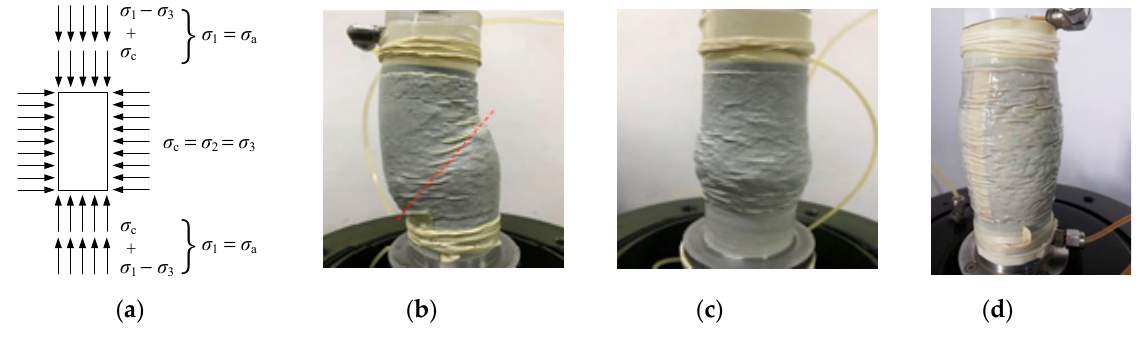
Figure 6. Stress State and Failure Mode of Specimens with a cement content of 3.5 g/100 mL. ( a ) Sample stress state, ( b ) Failure mode with X = 10%, ( c ) Failure mode with X = 20%, ( d ) Failure mode with X = 30%.